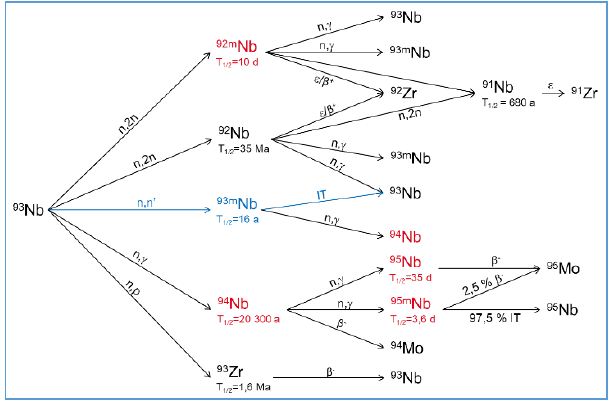
Fig. 1. Activation products from